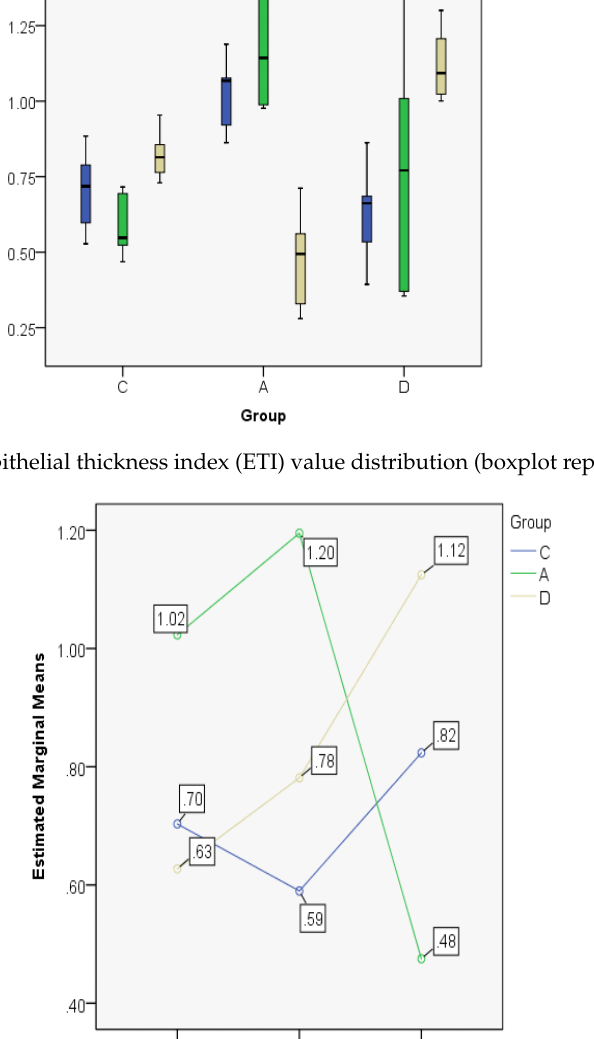
Figure 11. Epithelial thickness index (ETI) values, MANOVA test.